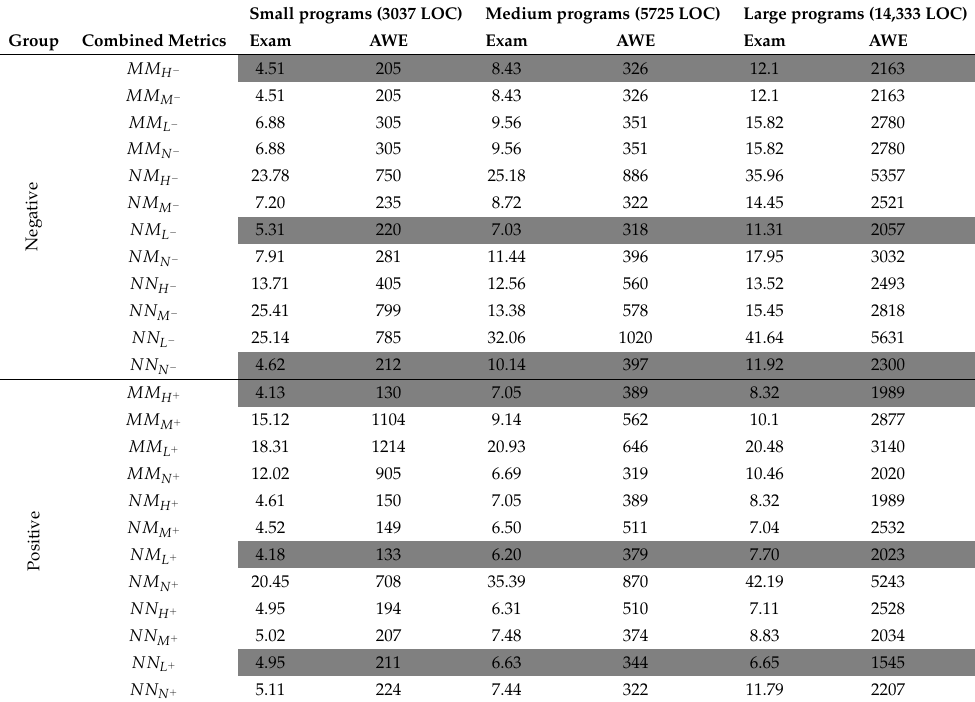
Table 5. Performance comparison of positively and negatively correlated combined-risk evaluation metrics. The highlighted metrics performed the best in each group and are shortlisted for further